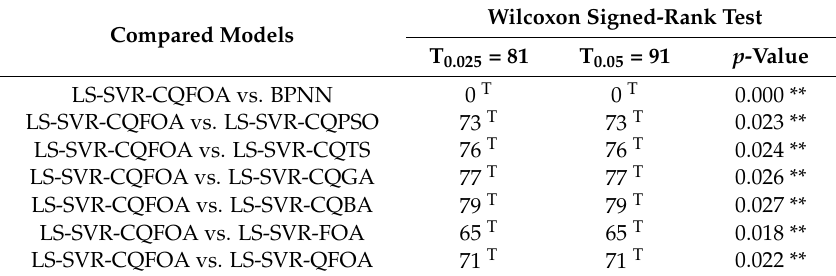
Table 12. Results of Wilcoxon signed-rank test for GEFCom2014